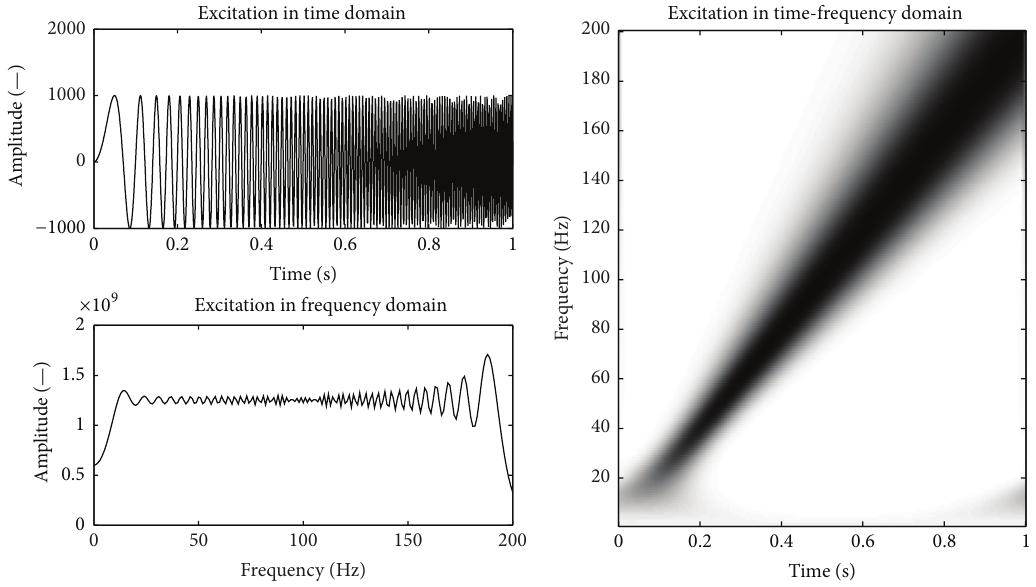
Figure 3: Chirp excitation given in the time, frequency, and combined time-frequency domains.